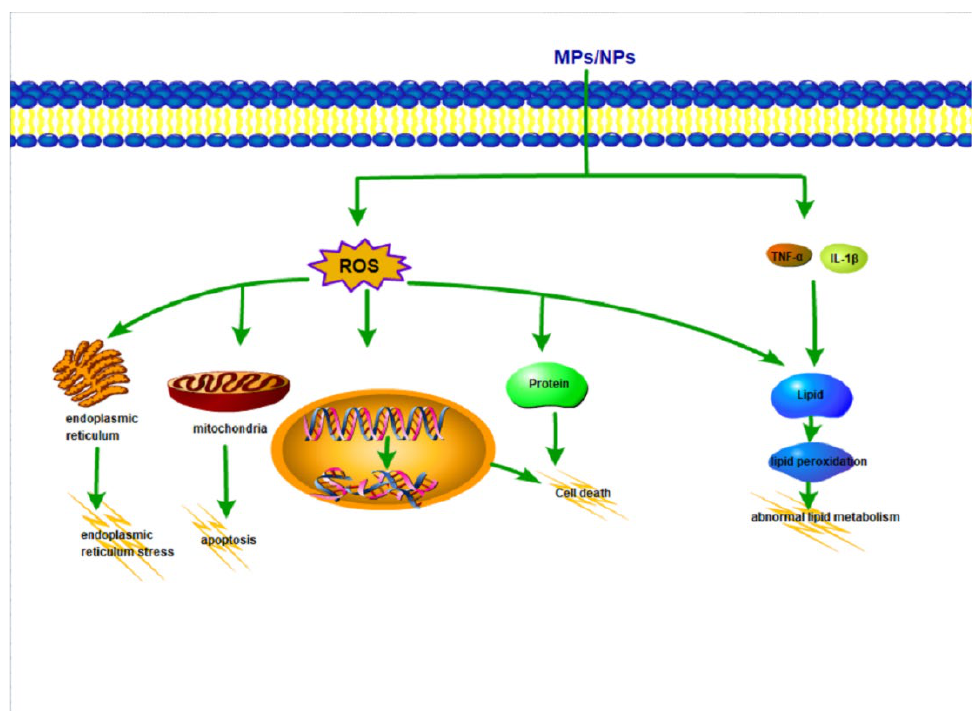
Figure 6. The interrelated cellular parameters.